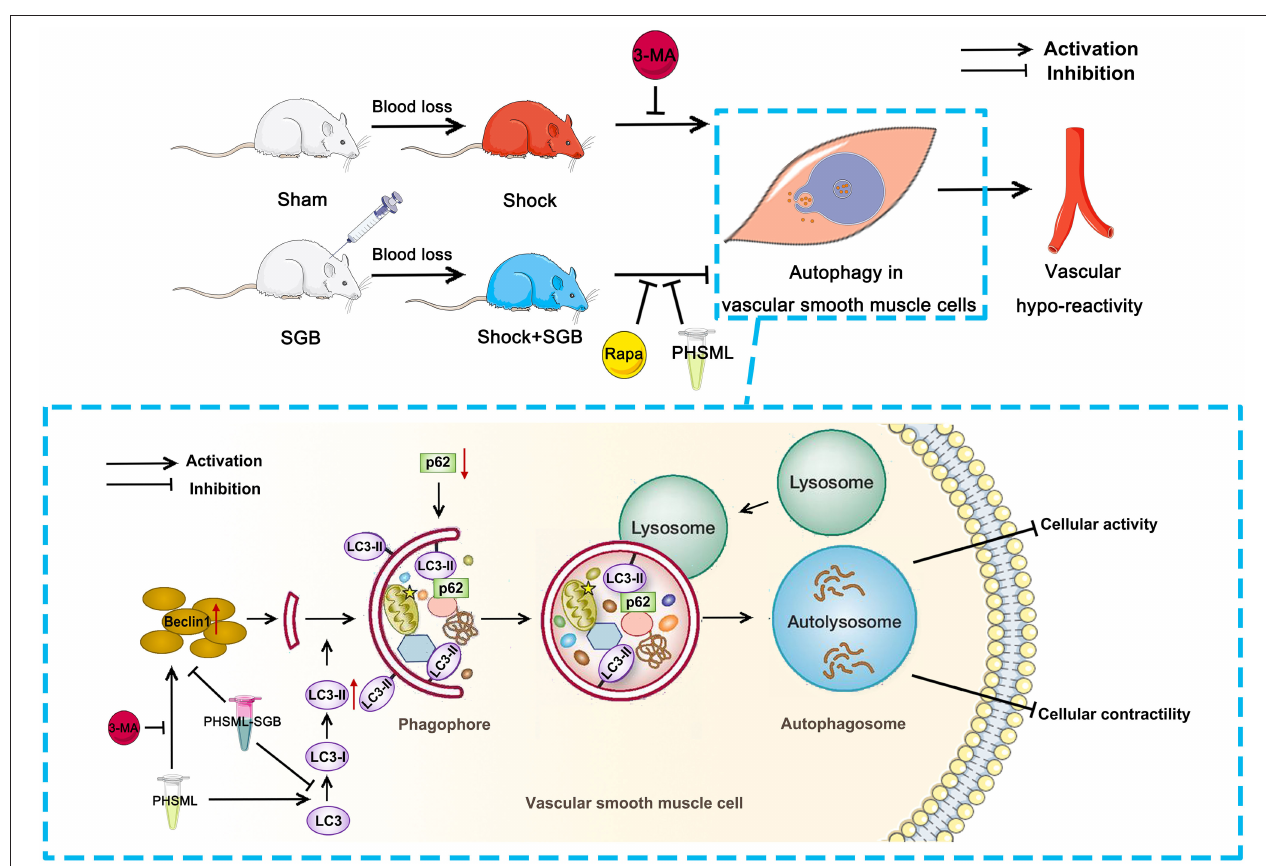
FIGURE 6 | The SGB inhibits the PHSML-mediated vascular hyporeactivity by reducing the excessive autophagy in VSMCs. SGB treatment and autophagy inhibitor 3-MA administration abolish hemorrhagic shock-induced vascular hyporeactivity, while the intravenous infusion of PHSML reverses the beneficial effects of SGB. Furthermore, PHSML incubation inhibits cellular contractile response and induces autophagy of VSMCs with evidence of increased expressions of LC3-II/LC3-I and Beclin 1 and decreased expression of p62, which was reversed by 3-MA treatment. Importantly, PHSML obtained from the rats underwent hemorrhagic shock plus SGB treatment (PHSML-SGB) has a reverse effect compared with